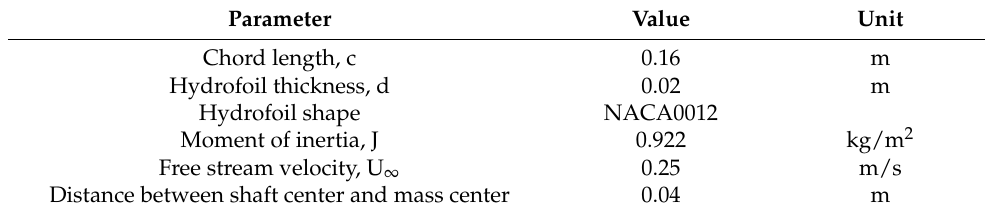
Table 3. Main parameters of the hydrofoil.